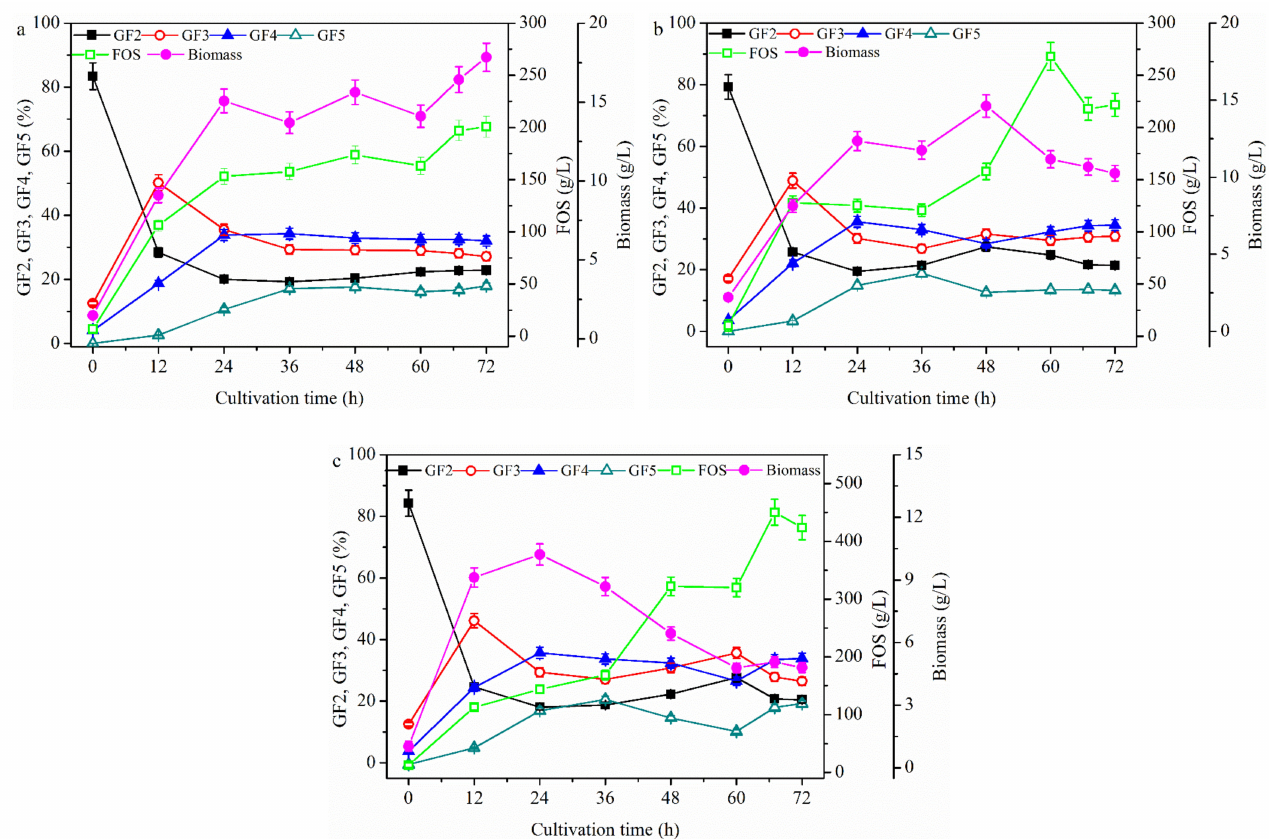
Figure 7. FOS production in a membrane integrated repeated batch culture. The repeated-batch cultivations at 600 rpm, aeration rate 1.8 L/min, and pH 5.5 were, respectively, carried out under 25 ◦ C ( a ), 35 ◦ C after culturing under 25 ◦ C for 12 h ( b ), and 35 ◦ C without starting the membrane after culturing under 25 ◦ C for 12 h ( c ). The working volume was 1.8 L. Data are given as the mean ± SD, n =